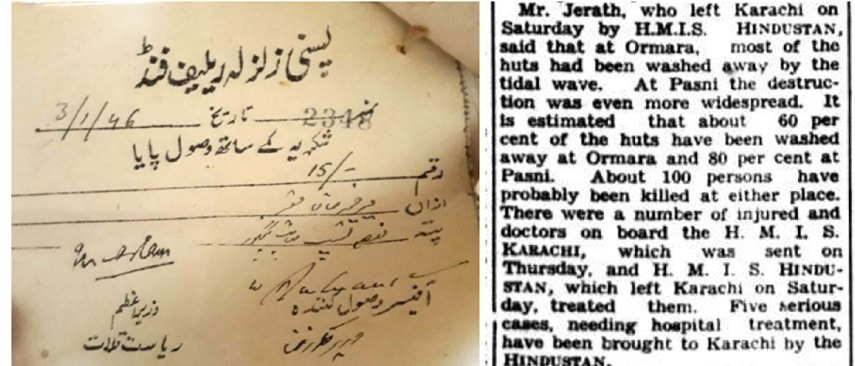
Figure 5. Relief efforts at Pasni and Ormara. Slip for an amount of PKR15 of the Pasni Relief Fund received by a survivor of the 1945 tsunami (on the left). The Times of India clipping showing that the director of Posts And Telegraph went on the HMIS Hindustan to Pasni and Ormara (on the